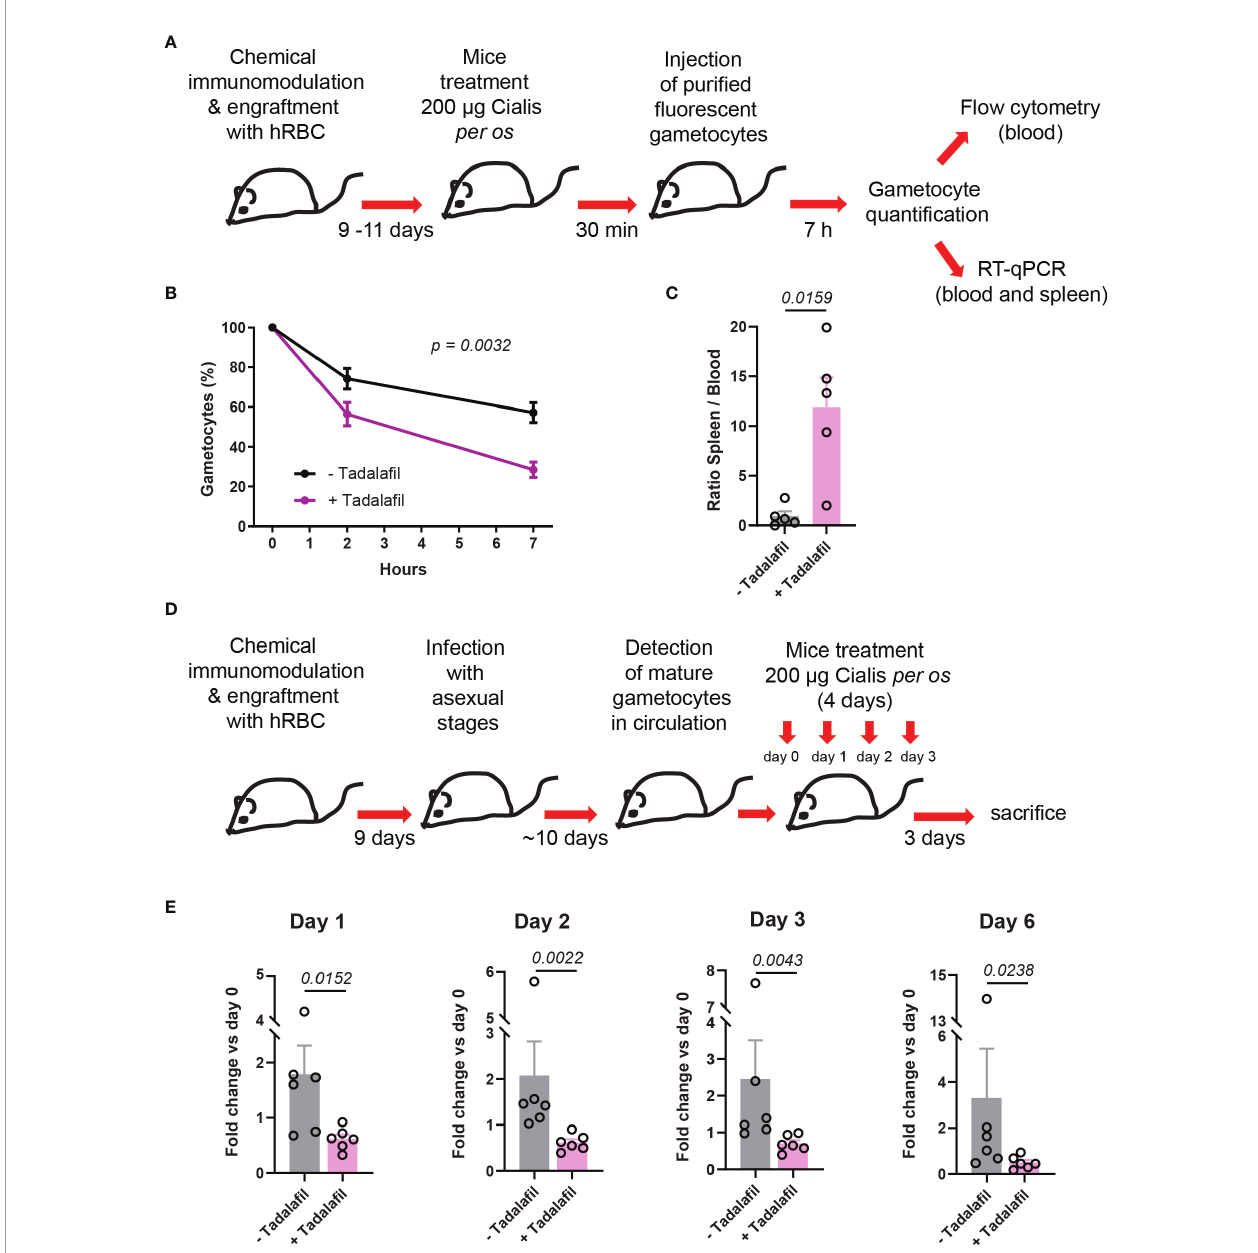
FIGURE 4 | Circulation of mature GIE is decreased in humanized mice treated orally with tadala fi l. (A) Schematic of experimental procedure for immunomodulation treatment and hRBC engraftment of NSG mice before injection with NF54-pfs47-hsp70-GFP stage V GIE. Mice were orally treated with Cialis 30 min before stage V GIE injection. GIE quanti fi cation was performed at 7 hpi by fl ow cytometry and RT-qPCR. (B) Quanti fi cation of stage V GIE clearance in peripheral blood, comparing tadala fi l-treated (violet) and untreated mice (black) by fl ow cytometry (n = 5 mice from 3 independent experiments). The percentage of gametocytes is normalized to the gametocytemia at 10 minutes after injection. p indicates the statistical signi fi cance determined using a two-way ANOVA test. (C) Quantitative analysis by real time RT-qPCR of GIE distribution in peripheral blood and spleen. Results were calculated as gfp transcript copy number using the absolute quanti fi cation method. Circles indicate the number of mice from 3 independent experiments. p indicates the statistical signi fi cance determined using a Mann Whitney test. (D) Experimental procedure for immunomodulation treatment and hRBC engraftment of NSG mice before infection with P. faciparum asexual parasites. Mice were treated orally with Cialis during 4 days and gametocytemia was monitored in thin tail-blood smears collected daily until sacri fi ce at day 6 after initiating drug treatment (n = 6 mice from 2 independent experiments). (E) Quanti fi cation stage V GIE in circulation at day 1, day 2, day 3 and day 6 after initiating the treatment. Gametocytemia was determined by counting 2000 to 4000 erythrocytes on thin tail-blood smears. p indicates the statistical signi fi cance determined using a Mann Whitney test. Circles indicate the number of mice from 2 independent experiments. Error bars show the